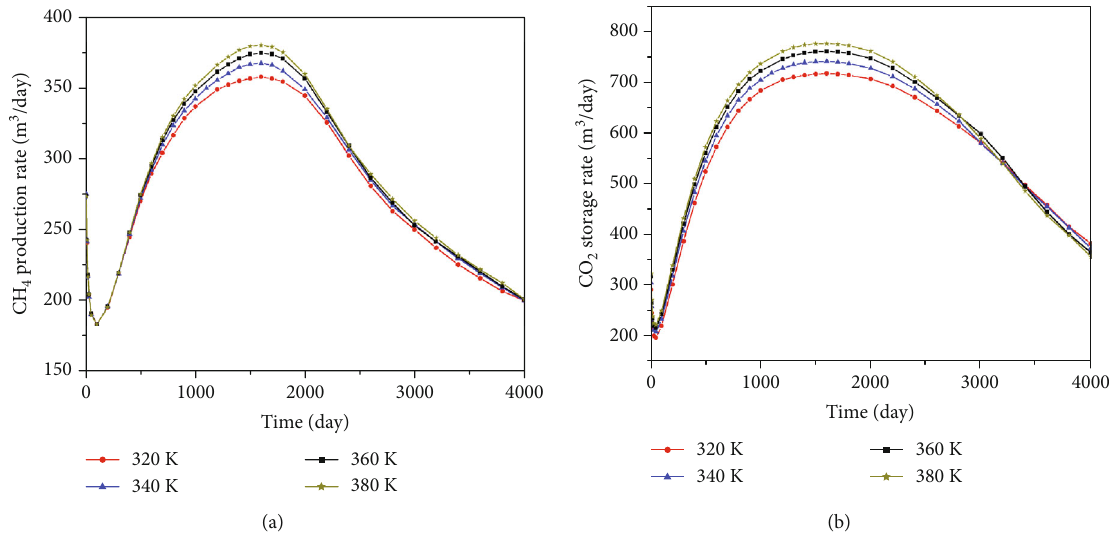
Figure 24: Evolution of CH